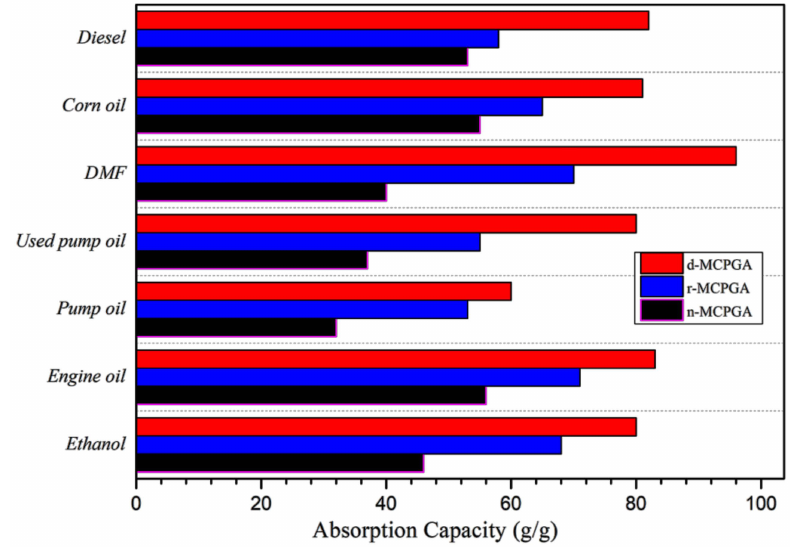
Figure 11. Absorption capacity of MCPGA (d-MCPGA, r-MCPGA, n-MCPGA) for di ff erent oils and organic